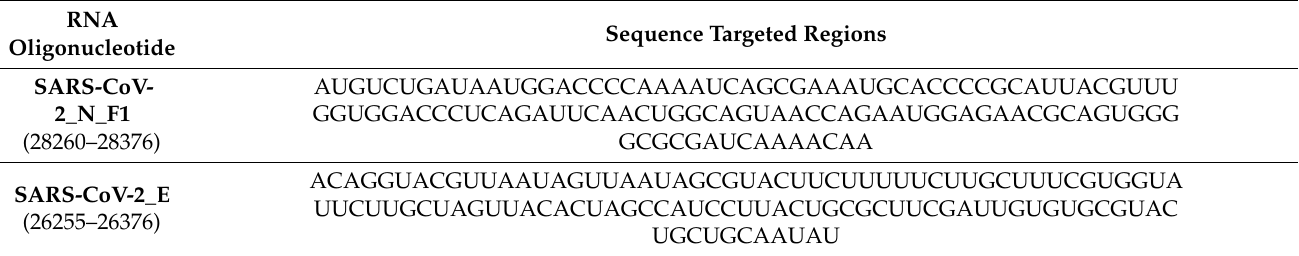
Table 4. Primers used for the Spike generation